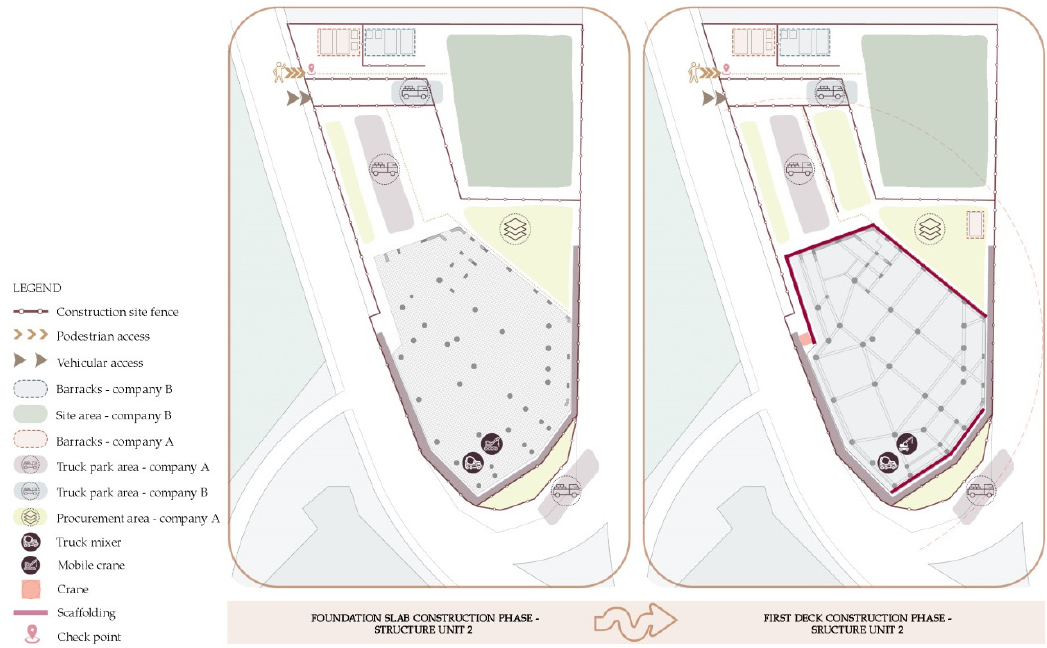
Figure 5. Foundation slab and first deck construction layouts—Case study.